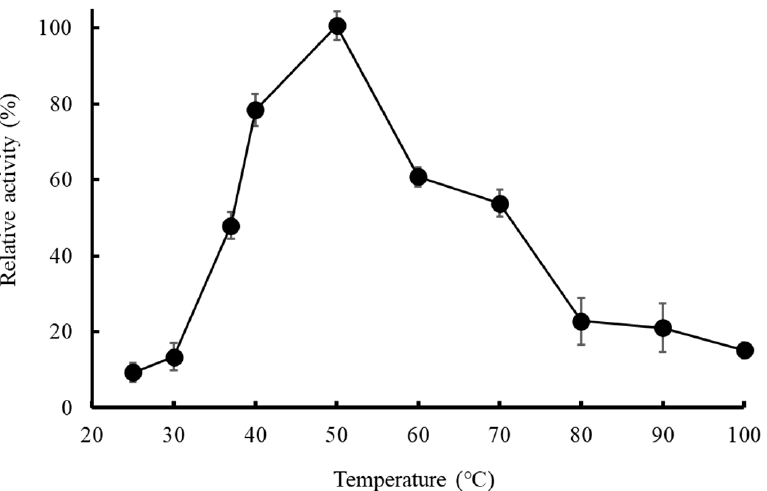
Figure 5. Temperature-dependent activities of the purified MD2-SBro. The highest activity at 50 °C (19.77 × 10 − 3 U/mg) was adjusted as 100%.